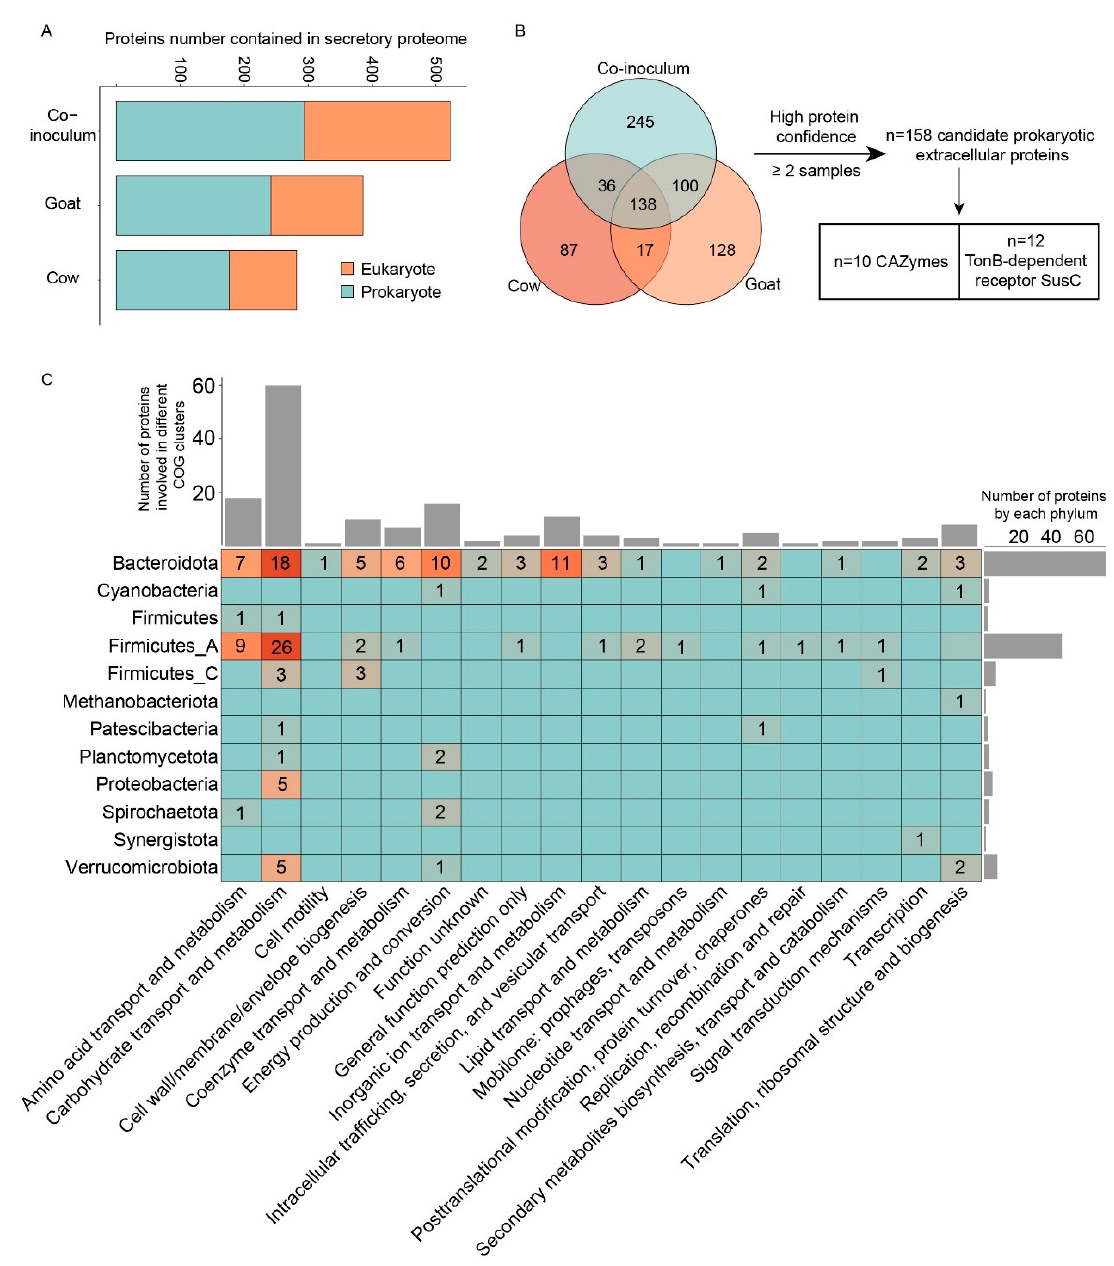
Figure 3. Functional characterization of extracellular proteins derived from microorganisms. ( A ) The number of proteins identified from the extracellular metaproteome of three fermentation broth samples. ( B ) Annotation information of extracellular proteins with high FDR confidence and identified from ≥ 2 samples. ( C ) Distribution of identified extracellular proteins in different COG categories and different microbial taxa.